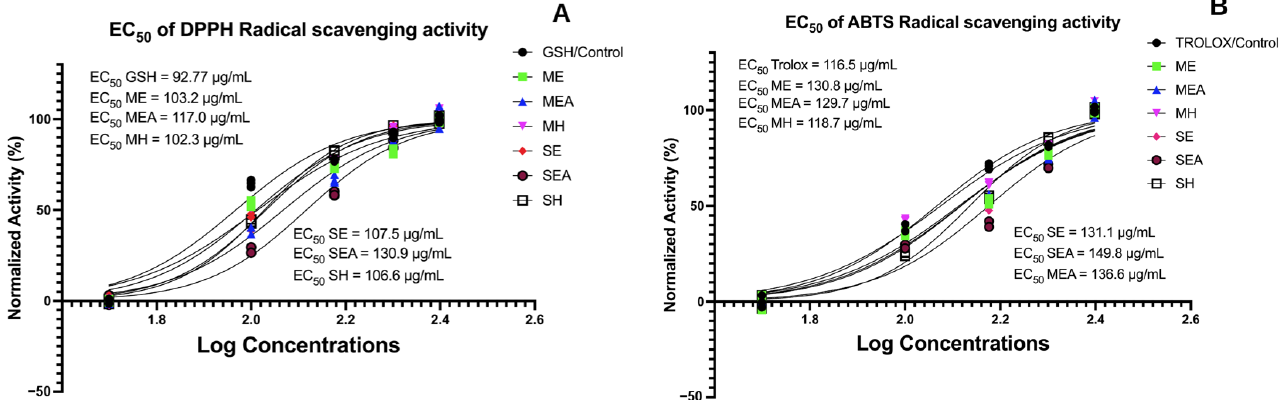
Figure 1. Antioxidant capacity of C. lentillifera . ( A ) The half ‐ maximal effective concentration (EC 50 ) of DPPH radical scavenging activity. ( B ) The half ‐ maximal effective concentration (EC 50 ) of ABTS radical scavenging activity. ME : Maceration — Ethanol; MEA : Maceration — Ethyl Acetate; MH : Maceration — n ‐ Hexane; SE : Soxhletation — Ethanol; SEA : Soxhletation — Ethyl Acetate; SH : Soxhletation — n ‐ Hexane.